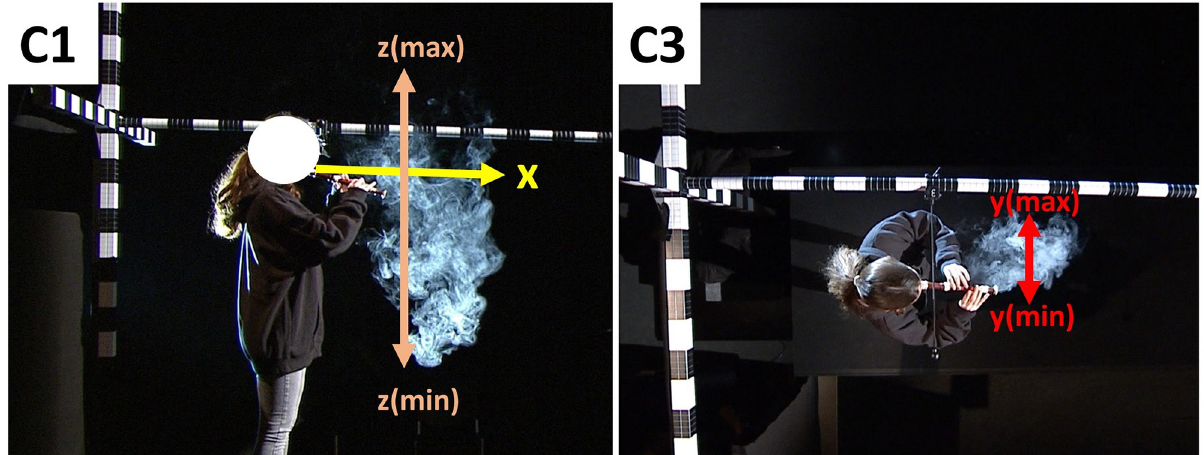
Fig 2. Display of the camera perspectives. Pictures of camera C1 (left) recording the x-dimension to the front and the vertical z-dimension from a side view, and camera C3 (right) recording the lateral y-dimension from a top view.